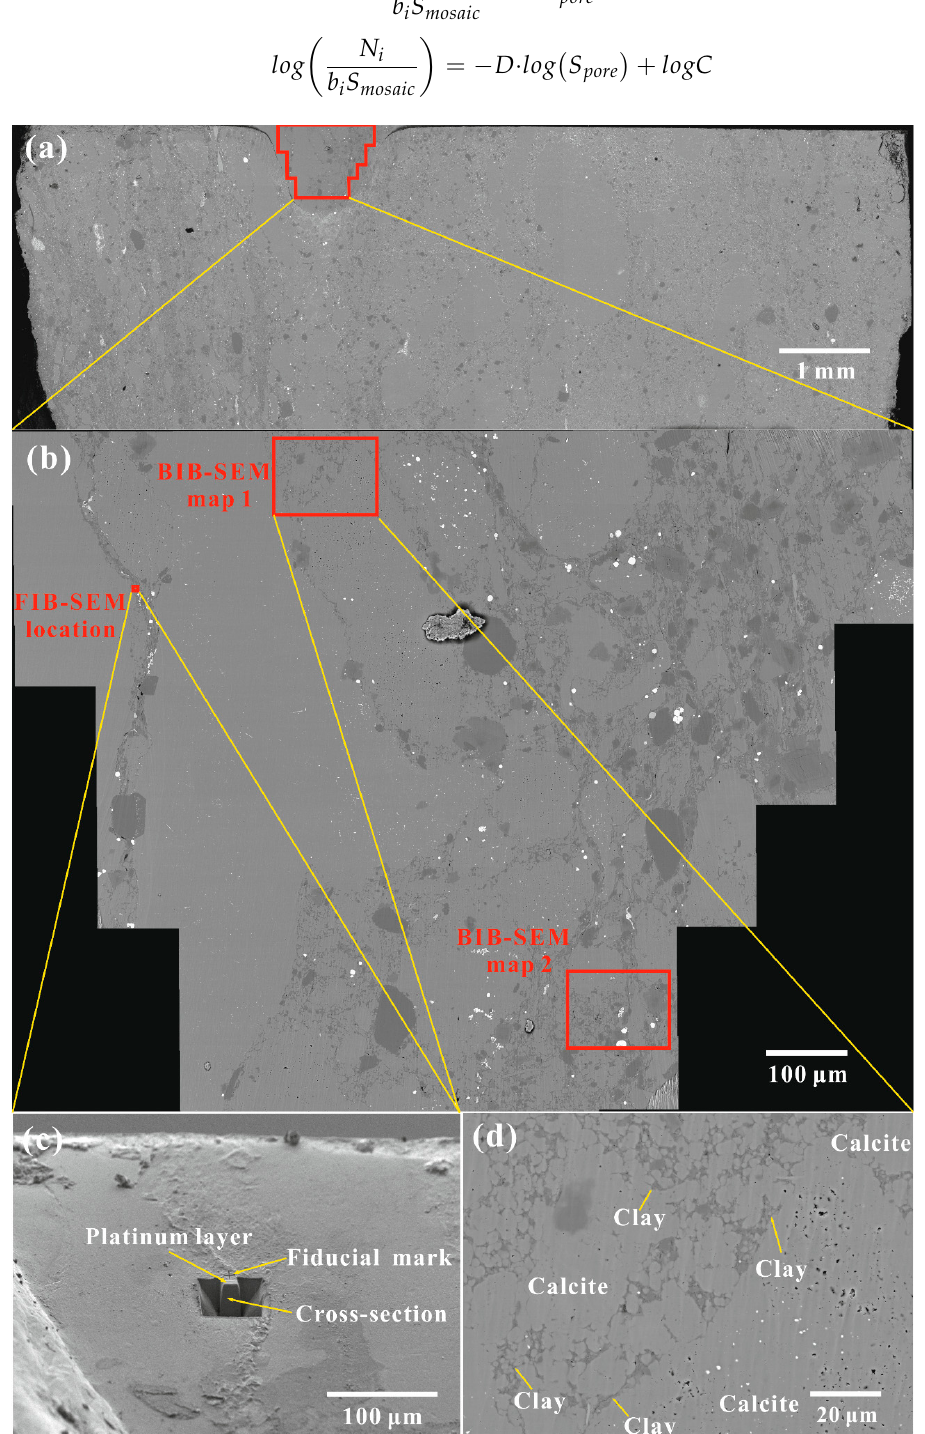
Figure 2. Overview of the studied section and the corresponding regions for BIB- and FIB-SEM. ( a ) Cross-section of the micro-core which is shown in Figure 1. ( b ) BSE image (0.72 mm 2 ) of BIB-polished region. Maps 1 and 2 were analyzed quantitatively for mineral composition and pore size distributions. The region for FIB-SEM is located on the upper left corner. ( c ) The location for FIB-SEM and the exposed cross-section. ( d ) The BSE image of map 1 showing the distribution of porous calcite and clay.